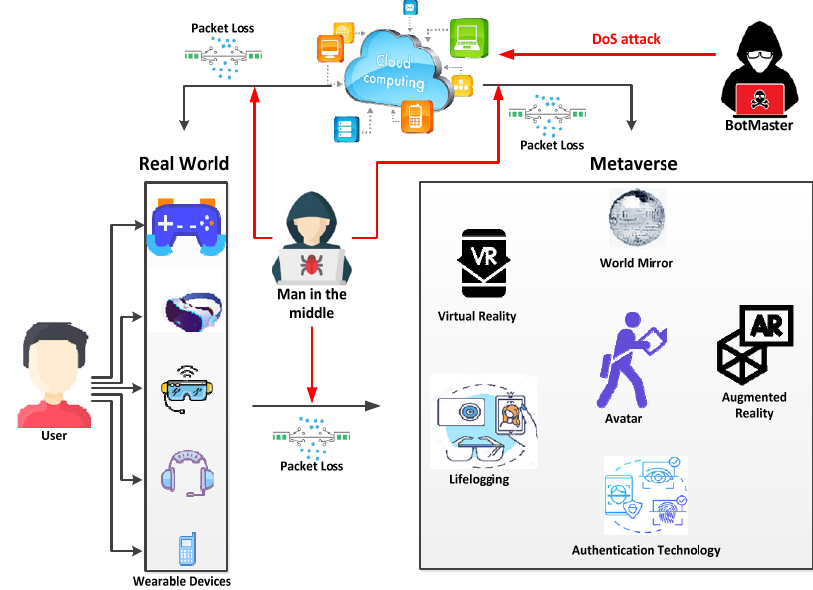
Figure 3. Common types of attacks on virtual reality learning systems.